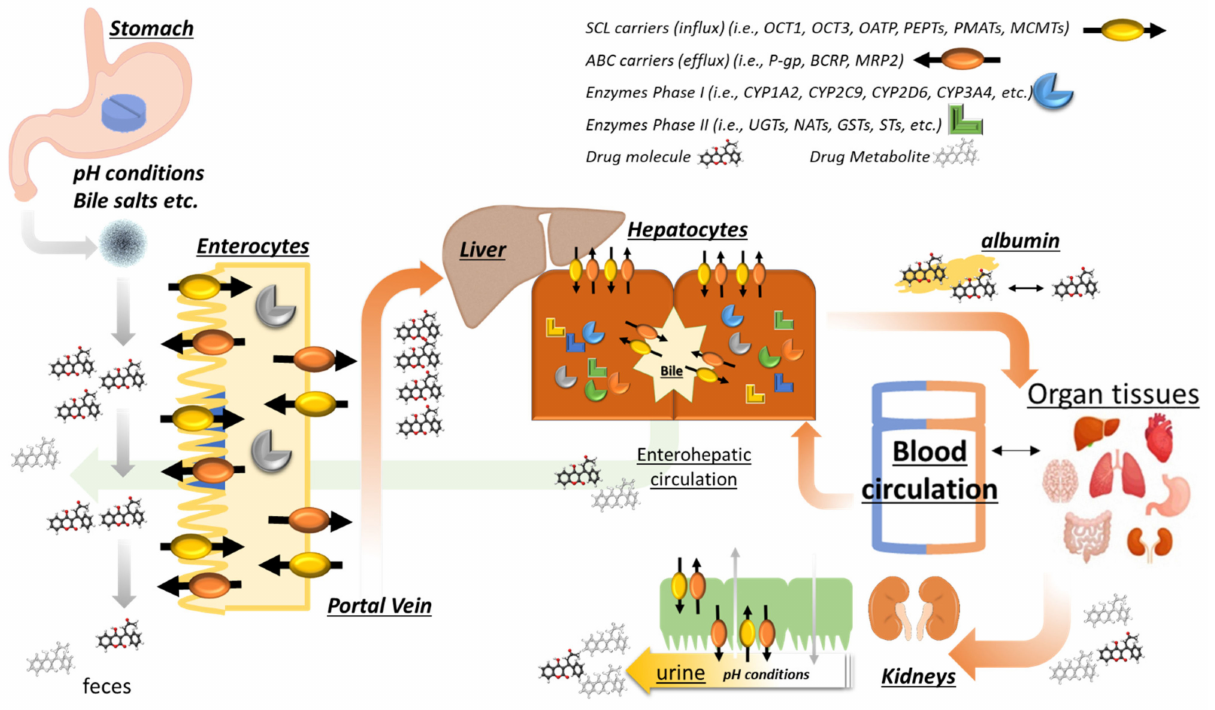
Figure 3. Pharmacokinetic processes for orally administered drugs and sites of potential